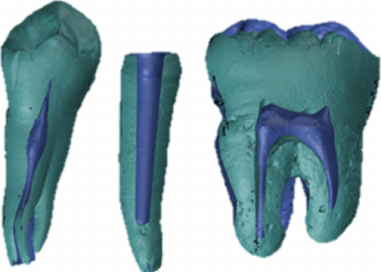
Figure 3. µ -CT reference dataset of a test model with prepared study tooth and adjacent teeth in representative cross section.